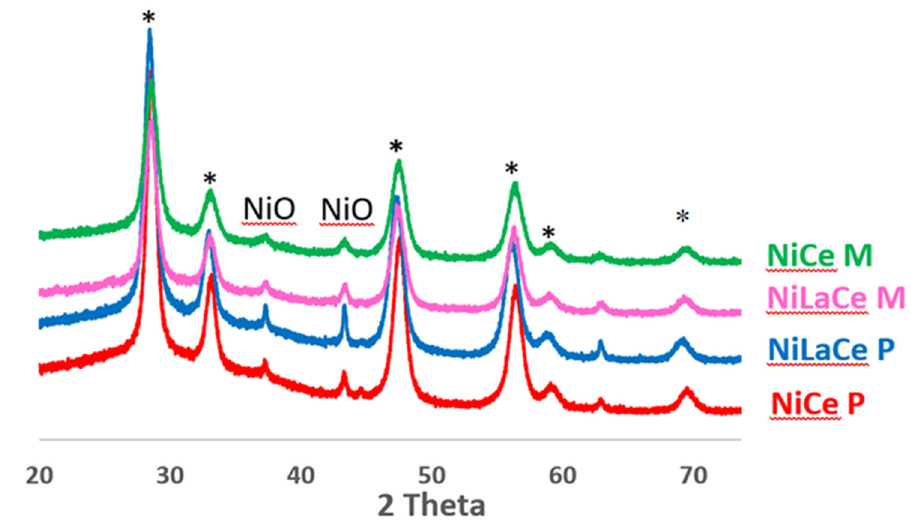
Figure 4. XRD patterns of fresh catalysts after calcination. (* denoted peaks of ceria crystal phases.) As for the fresh samples, XRD profiles showed a fluorite-type phase of ceria with characteristic reflections at 2 θ = 28°, 33°, 47°, 56°, 59°, and 69° associated with (111), (200), (220), (311), (222) and (400) planes of the cubic phase, respectively [33]. No diffraction lines related to lanthanum nor lanthanum oxide can be evidenced in XRD spectra, despite its almost 5 wt % loading. This could be reasonably due to the incorporation of La 3+ ions in the ceria lattice [18]. A mean size of 11 and 9 nm was calculated by Sherrer for the crystal particle size of CeO 2 , respectively, in NiCeP and NiCeM. La addition does not significantly affect ceria size. Regarding the active phase, the occurrence of NiO was clearly detected, with the characteristic diffraction lines at 2 θ 37° and 43.4° [34]. The presence of nickel in its oxidic form was not unexpected, because the analyses have been performed on calcined catalysts, as the samples charged in the reactor for catalytic ESR testing. Table 1 shows the crystal size of NiO, calculated from the analysis of the most intense diffractions, corre- sponding to 2 θ = 43.4°. The patterns of the precipitated samples showed sharper and more intense diffraction lines, meaning that the particles of ceria and NiO were bigger and more crystalline than for the catalysts prepared via microemulsion (Table 1). These preliminary analyses indicated that the support preparation method strongly affected morphological and structural features of the final catalysts. Therefore, further characterizations were performed. TPR technique was used to identify the different NiO species on the ceria surface and their reduction features and to determine the support reduction temperature. The TPR profiles are reported in Figure 5. The most evident dif- ference between the TPR profiles of the two different techniques is the number of NiO species interacting with the support. The profiles of samples prepared by precipitation presented three broad reduction peaks at 204 °C, 249 °C and 329 °C that can be associated with NiO reduction. On the contrary, the TPR curves of samples synthesized by micro- emulsion showed only one sharp peak centered at 470 °C. Therefore, TPR analyses clearly showed that the synthetic approach has a deep effect on Ni reducibility, which could affect their catalytic behavior. NiO was reduced at temperatures below 400 °C for samples pre- pared by precipitation, while for catalysts synthesized by microemulsion the temperature needed for NiO reduction is at least 400 °C. This difference can be reasonably ascribable to the different metal–support interactions that can be formed during the oxide precipita- tion: the stronger the interaction, the higher the reduction temperature. The broad maxima at higher temperatures are related to the support, since it is known that the ceria can be reduced from Ce 4+ to Ce 3+ at temperatures above 700 °C [35]. As reported in the literature, one can envisage, for the precipitated supports, one small and broad peak at 800 °C, while